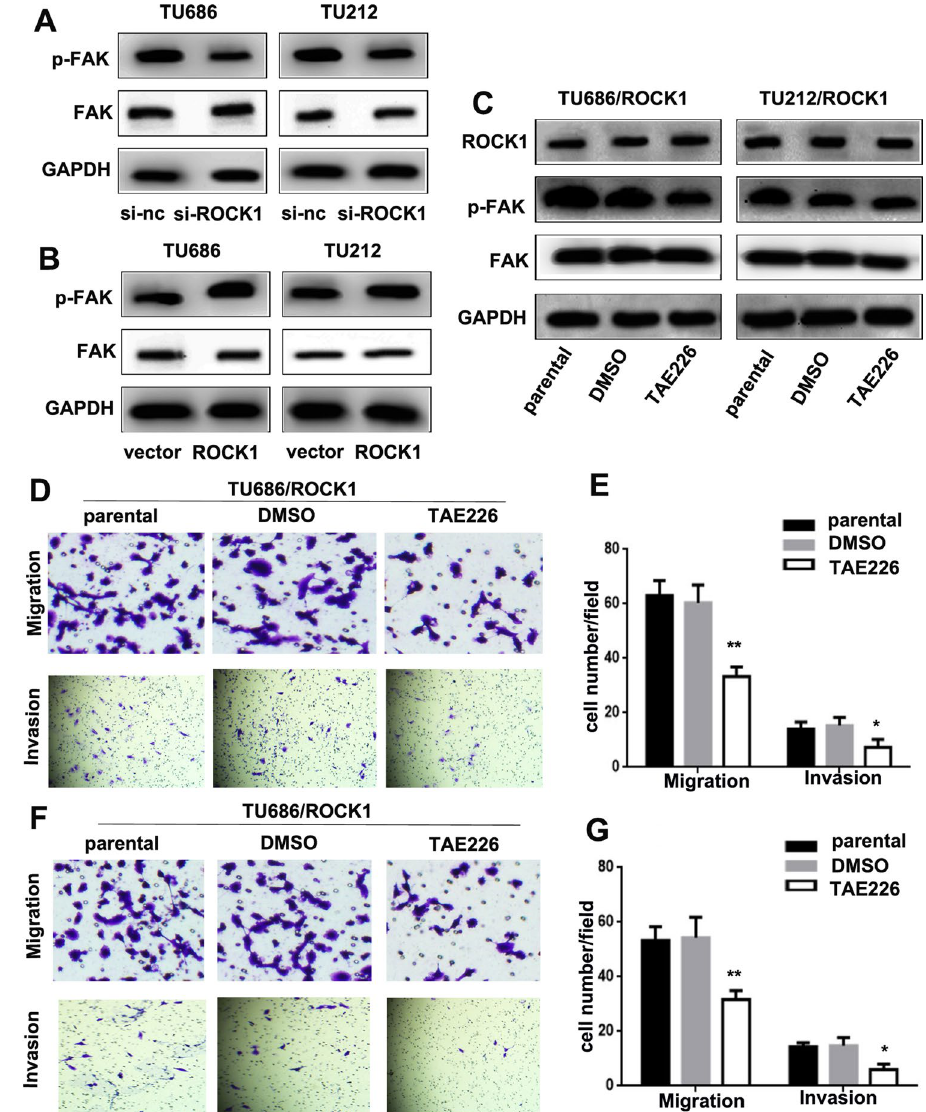
Fig. 4 ROCK1 promotes LSCC tumorigenesis and progression via the FAK path- way. A The expression levels of p-FAK and FAK in TU686/ si-ROCK1, TU212/si-ROCK1, TU686/si-nc and TU212/ si-nc cells were examined by Western Blot. B The expres- sion levels of p-FAK and FAK in TU686/ROCK1, TU212/ROCK1, TU686/vector and TU212/ vector cells were examined by Western Blot. C The expres- sion levels of ROCK1, p-FAK and FAK in TU686/ROCK1/ parental, TU686/ROCK1/ DMSO, TU212/ROCK1/paren- tal, TU212/ROCK1/DMSO, TU686/ROCK1/TAE226 and TU212/ROCK1/TAE226 cells were examined by Western Blot. D–G Inhibiting FAK activ- ity reduced TU686 and TU212 cell migration and invasion (*P < 0.05, **P <